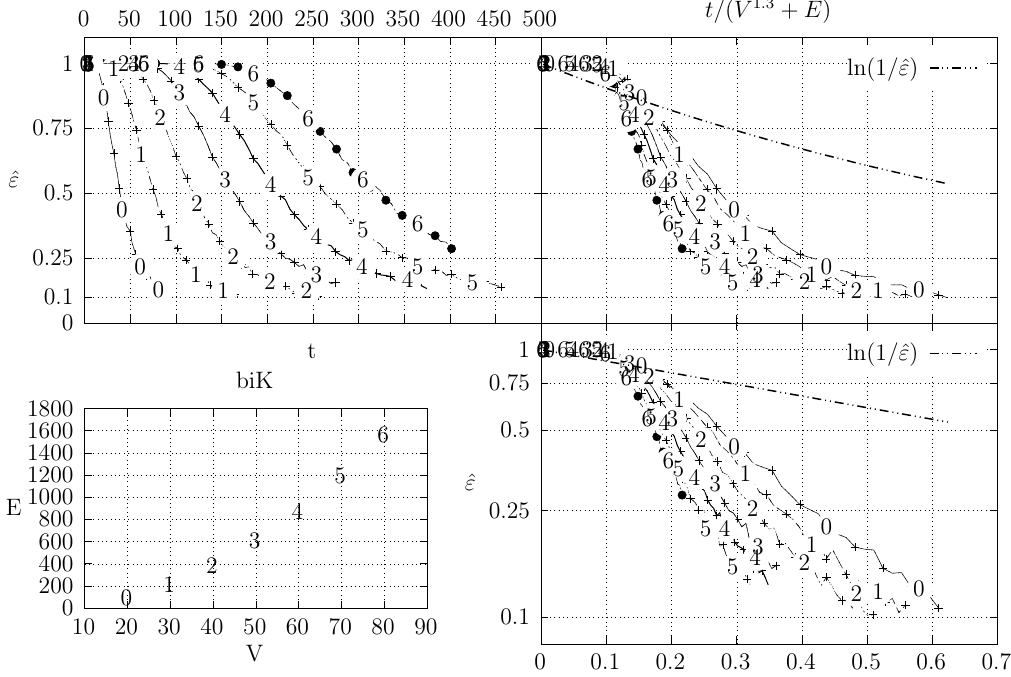
Figure 21. Estimation of variation distance as a function of the number of iterations for biK graphs (see Section 4.3.1 for details).